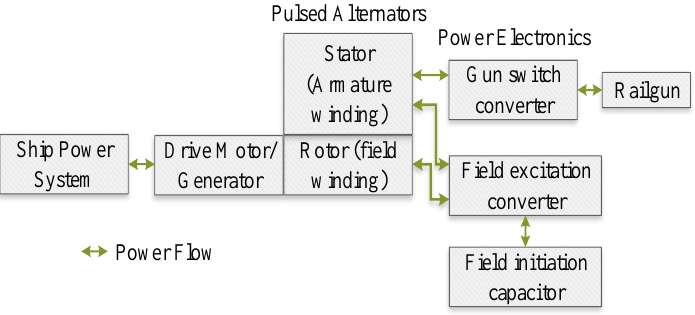
Figure 7. Basic block diagram of electromagnetic rail gun